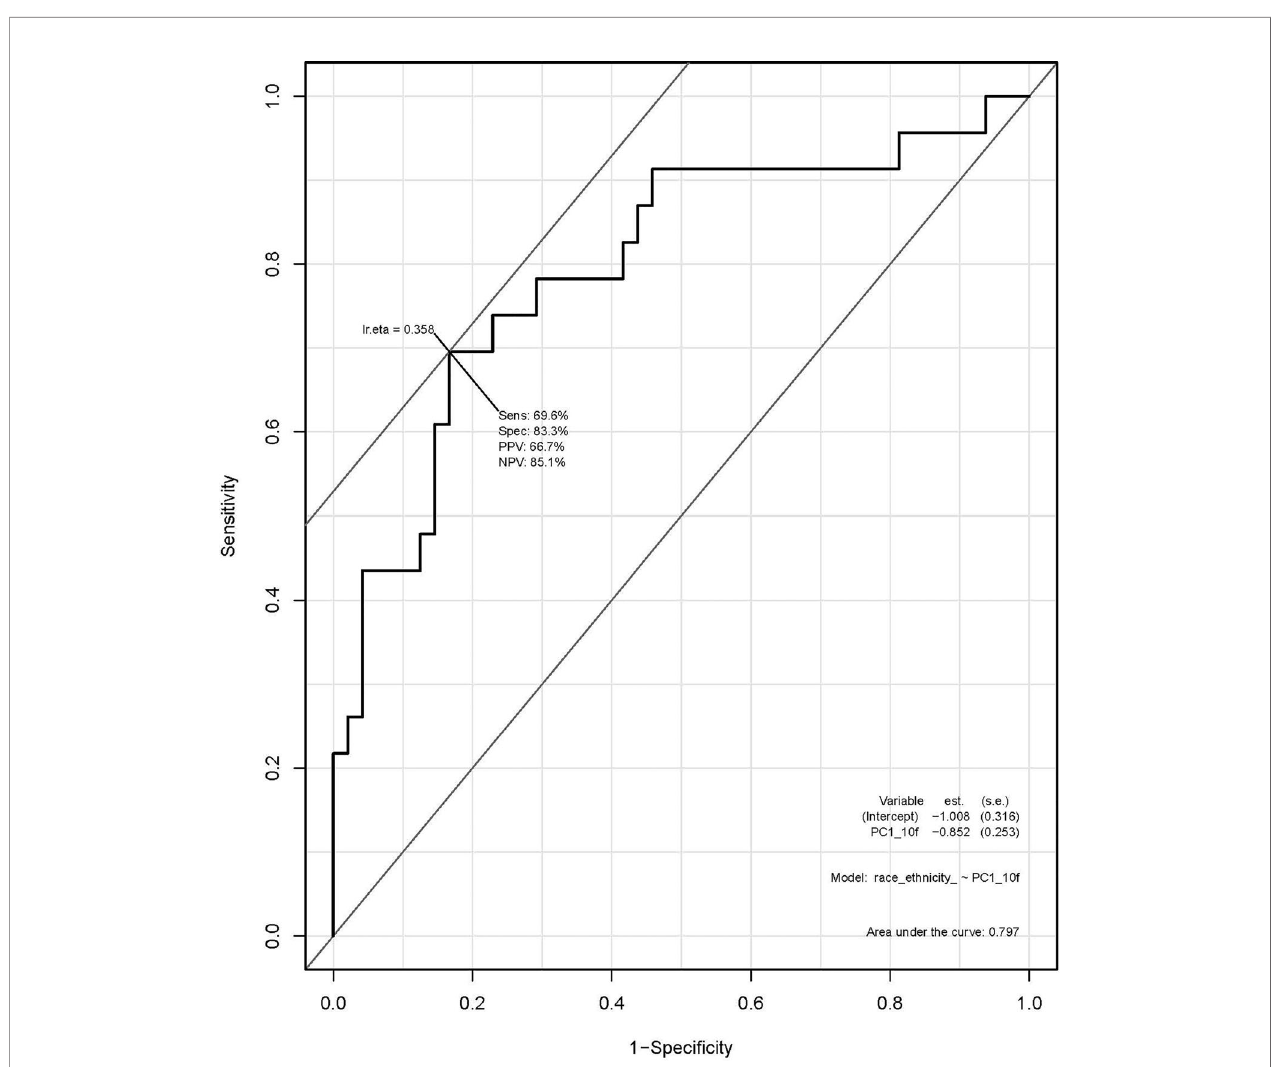
FIGURE 2 | Receiver operating characteristic (ROC) curve using principal component analysis to identify radiomic features predictive of race/ethnicity.